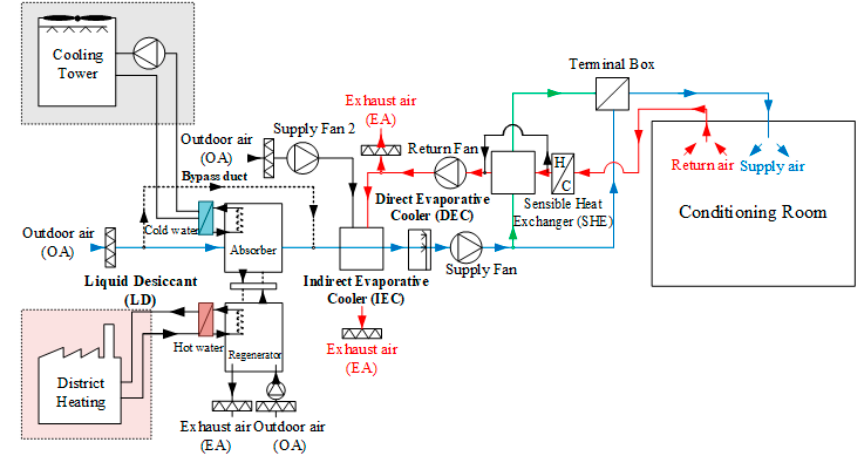
Figure 1. The schematic of LD-IDECOAS.